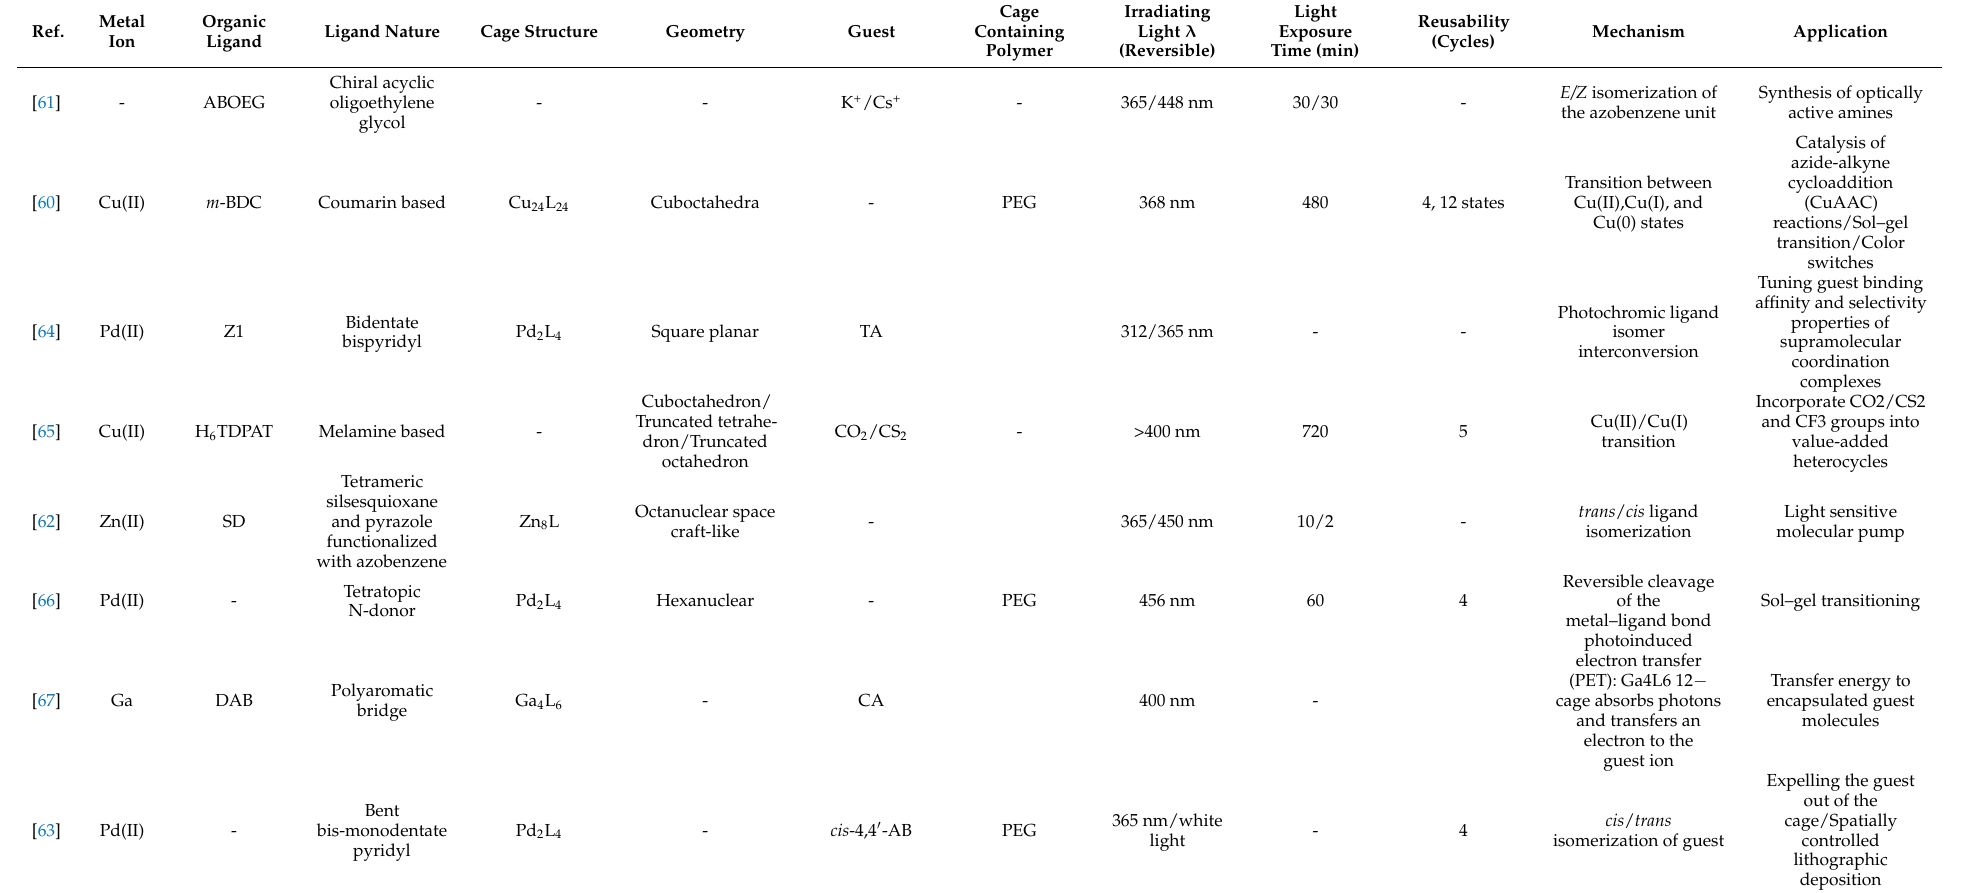
Table 1. Literature overview on MOCs’ synthesis and